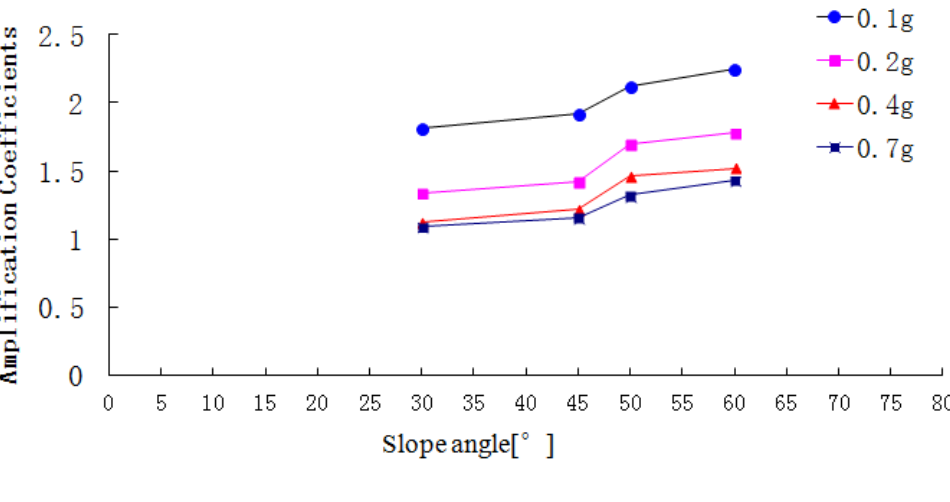
Figure 18. The peak acceleration amplification coefficient on the free face.